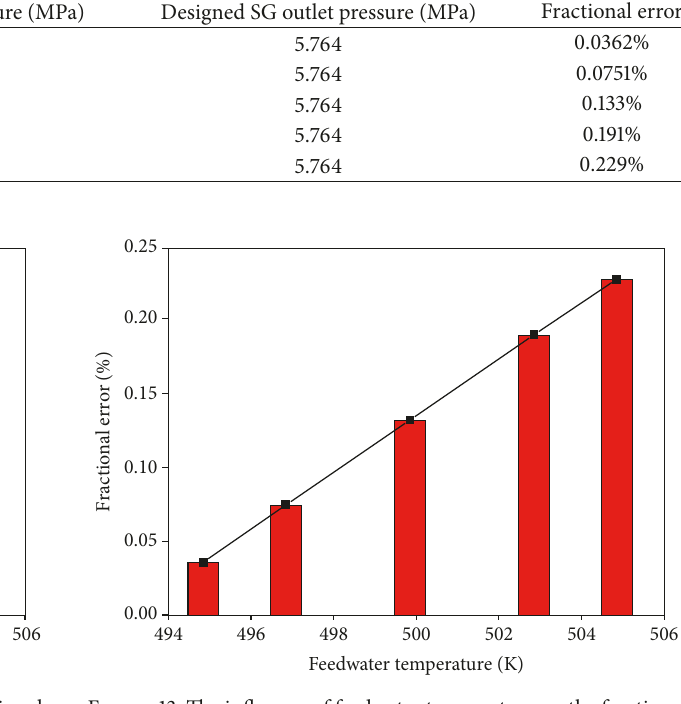
Figure 13: The influence of feedwater temperature on the fractional error between calculated and designed SG outlet